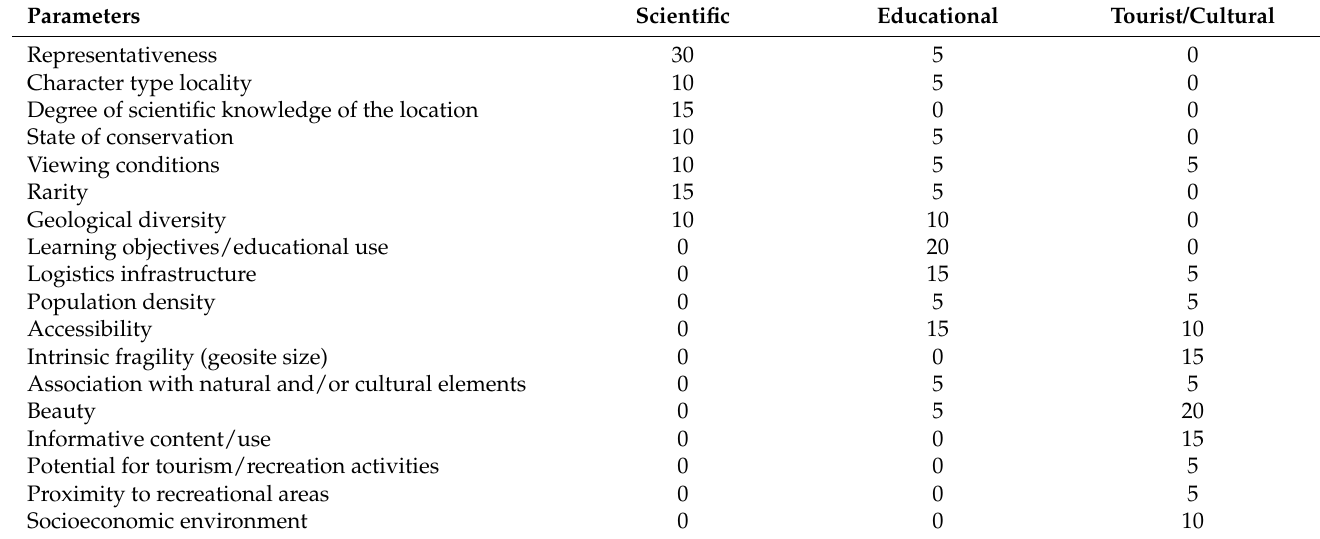
Table 1. Parameters that were studied and coefficients based on the value that was sought (scientific, educational and tourist).